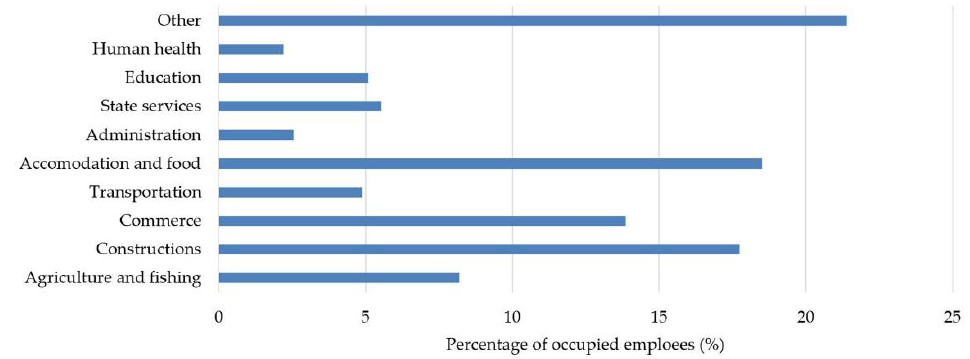
Figure 1. The map of Sifnos and its geographical location in Greece.